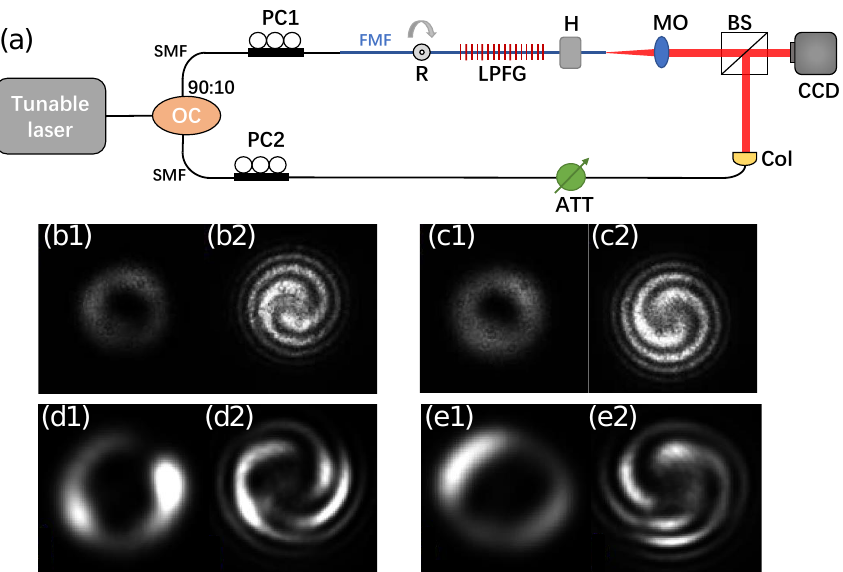
Figure 17. ( a ) Schematic diagram of the experimental setups for the generation and detection of OAM modes using asymmetric LPFGs. OC, optical coupler; H, holder; R, rotator; MO, microscope objective; ATT, attenuator; Col, collimator. ( b1 – e1 ) The intensity profiles of the generated modes. ( b2 – e2 ) The interference patterns of the generated OAM modes with a reference Gaussian beam. Adapted with permission from Refs. [24,25] © The Optical